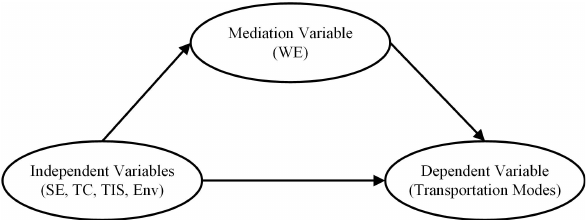
Figure 1: The general concept of model